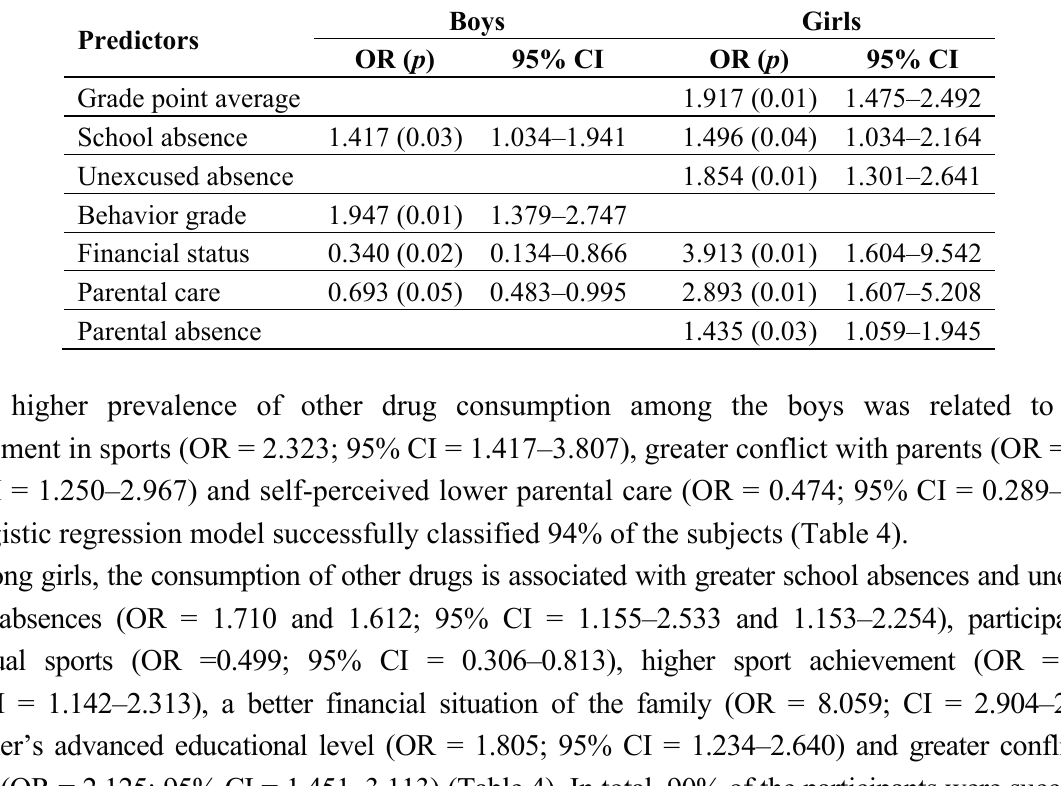
Table 3. Forward conditional logistic regression results for the criterion—simultaneous cigarette smoking and harmful drinking among boys and girls (OR—odds ratio; p —level of significance; CI—confidence